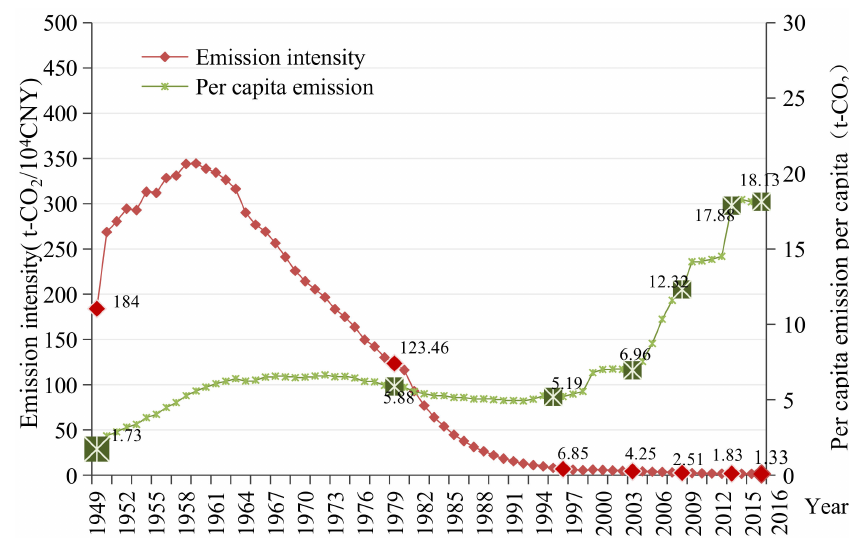
Figure 9. Emissions intensity and per capita emissions from 1949 to